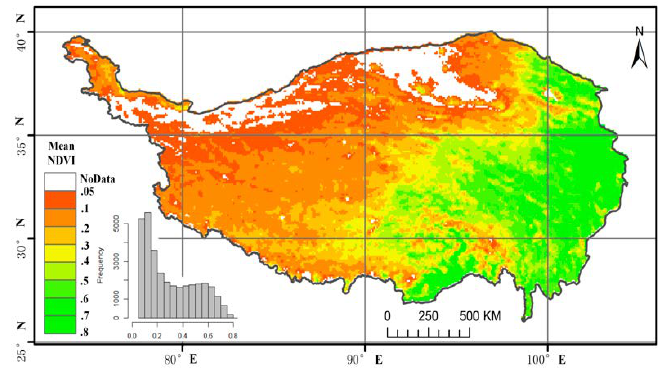
Figure 1. Multi-years mean of NDVI over Tibetan Plateau With regard to the long term trend of NDVI and phenology evolution, their pixel level temporal gradient was computed as the slope of a linear model fit through each year of the time period of interest, at the 5% significance level (Figure 2). The spatial pattern of NDVI is similar to that of mulitple years mean NDVI. The majority of the vegetated area show an increasing trend of NDVI. But there are some regions experienced a vegetation degrading process, particularly in the southern Tibetan Plateau (Figure 2a). For the phenology metrics trend analyses, the pixel value that is failing to extract phenological parameters is set as nodata in Figure 2c-2d. For SOS, there are a considerable number of pixels showing a inceasing trend in the southern and central part. This phenomenon indicates that plants greenup dates are delayed in the springtime. Whereas, plants andvanced greenup dates are reflected by the deceasing slope of the SOS trends in the eastern and western part of the plateau (Figure 2b). For EOS, positive trend means the delayed cessation in the fall. While negative EOS slope reflects the advanced offset of growing season. There are more than 75% of EOS trend pixels showing a negative value. Based on the SOS and EOS dates, we calculated the LOS length, in which positive slope indicates a prolonged growsing season period. In the northwestern region and part of the southern region, LOS display a shortened condition (red color in Figure 2d, about 67% in the valid